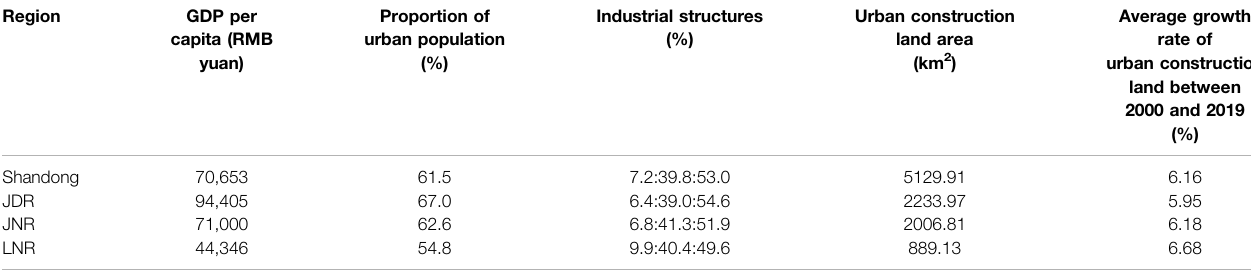
TABLE 5 | Economic statistics of Shandong province and its three sub-regions. Region